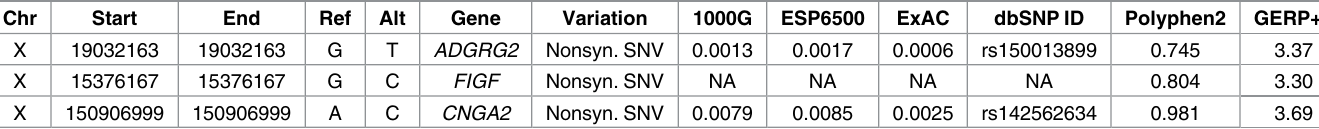
Table 2. Details of the hemizygous variations found in the exome of the male sibling.